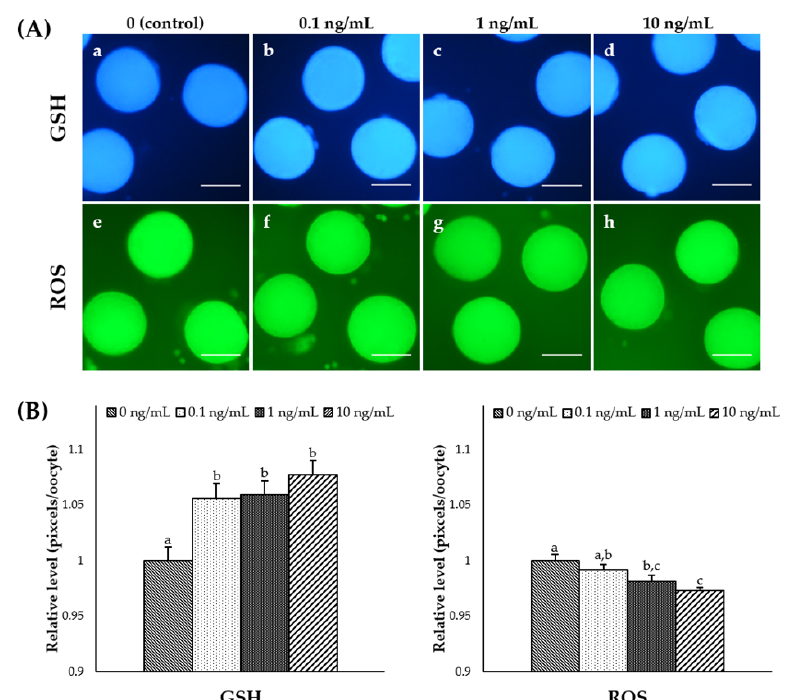
Figure 1. Epifluorescence photomicrograph images of in vitro matured porcine oocytes. ( A ) Oocytes stained with Cell Tracker Blue (a–d) and H 2 DCFDA (e–h) to detect intracellular levels of glutathione (GSH) and reactive oxygen species (ROS), respectively. Metaphase II (MII) oocytes derived from the control in vitro maturation (IVM) system and the IVM system supplemented with various concentrations of interleukin-7 (IL-7). ( B ) The relative levels of intracellular GSH and ROS levels in in vitro matured porcine oocytes treated with IL-7 during IVM. The bars with different letters (a–c) are significantly different ( p < 0.05). GSH samples, N = 60; ROS samples, N = 60. The experiment was replicated three times. Scale bar: 100 μ m.